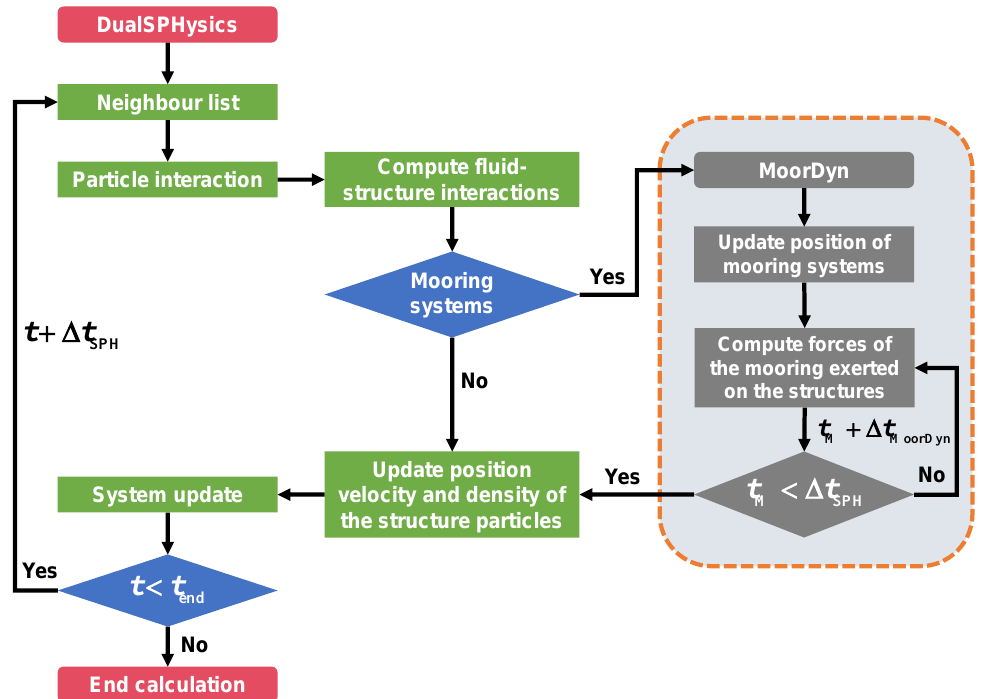
Figure 15. The flow chart of the coupling process between DualSPHysics and MoorDyn (adapted from [120]).